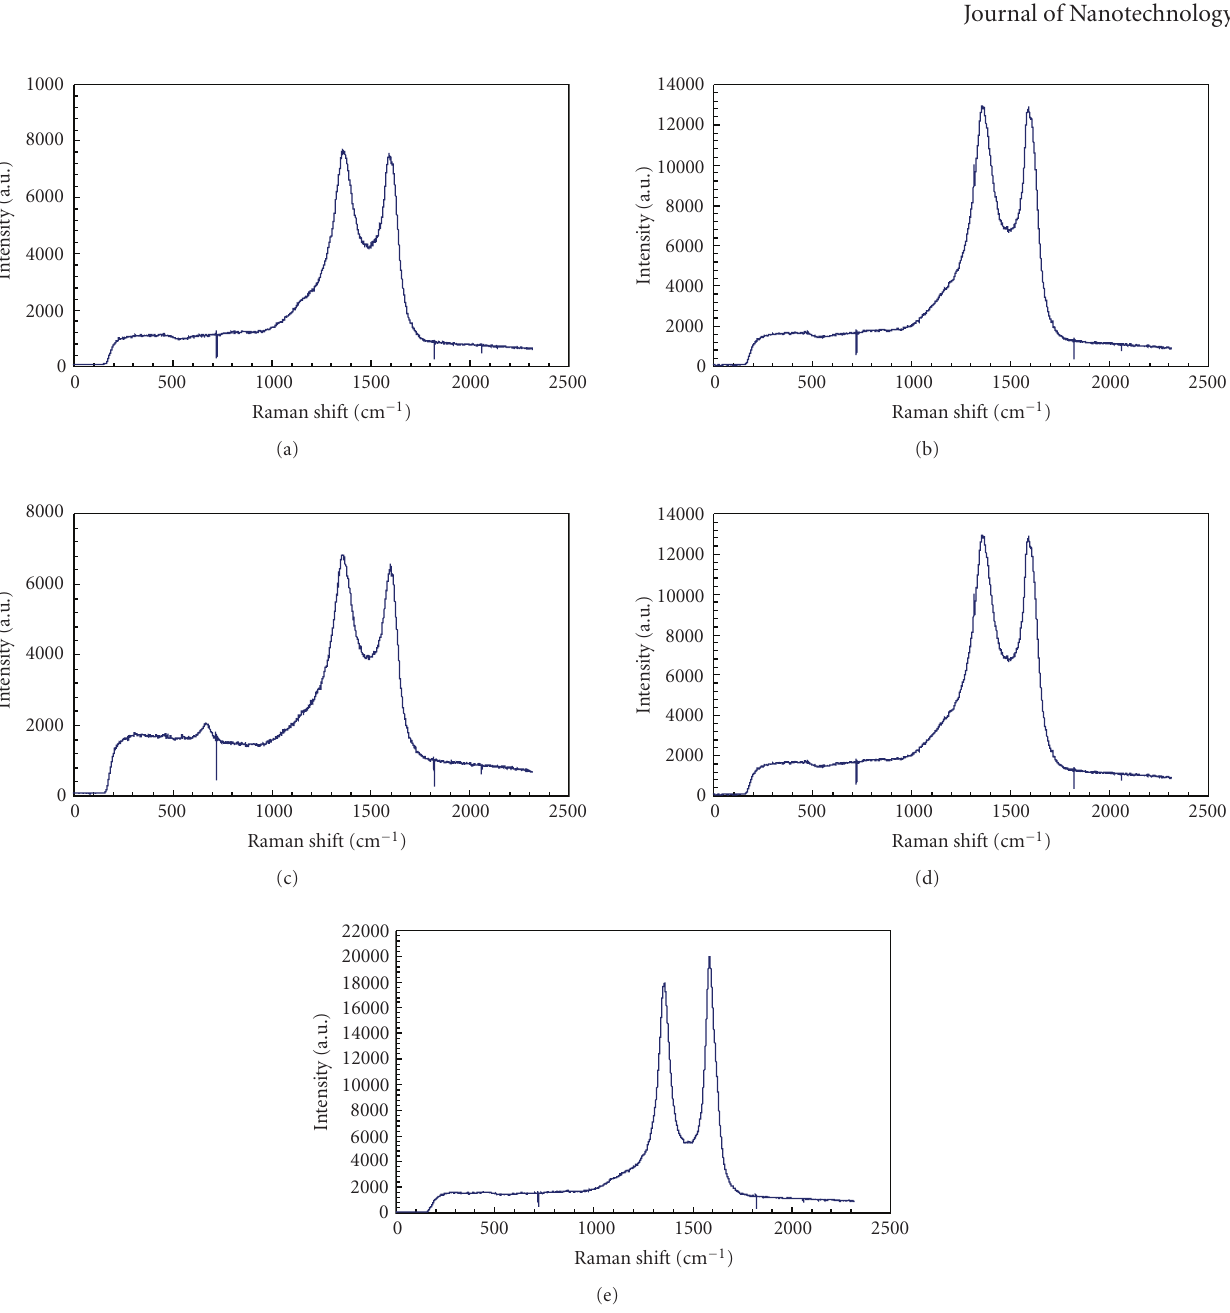
Figure 12: Raman spectrum for (a) carbon fiber with removed sizing, (b) carbon fiber with iron deposition via electrochemical deposition, (c) carbon fiber with iron deposition via Dc magnetron sputtering, (d) carbon fiber with surface grown MWCNTs (iron was deposited using electrochemical multipotential, and (e) carbon fiber with surface grown MWCNTs (iron was deposited using DC magnetron